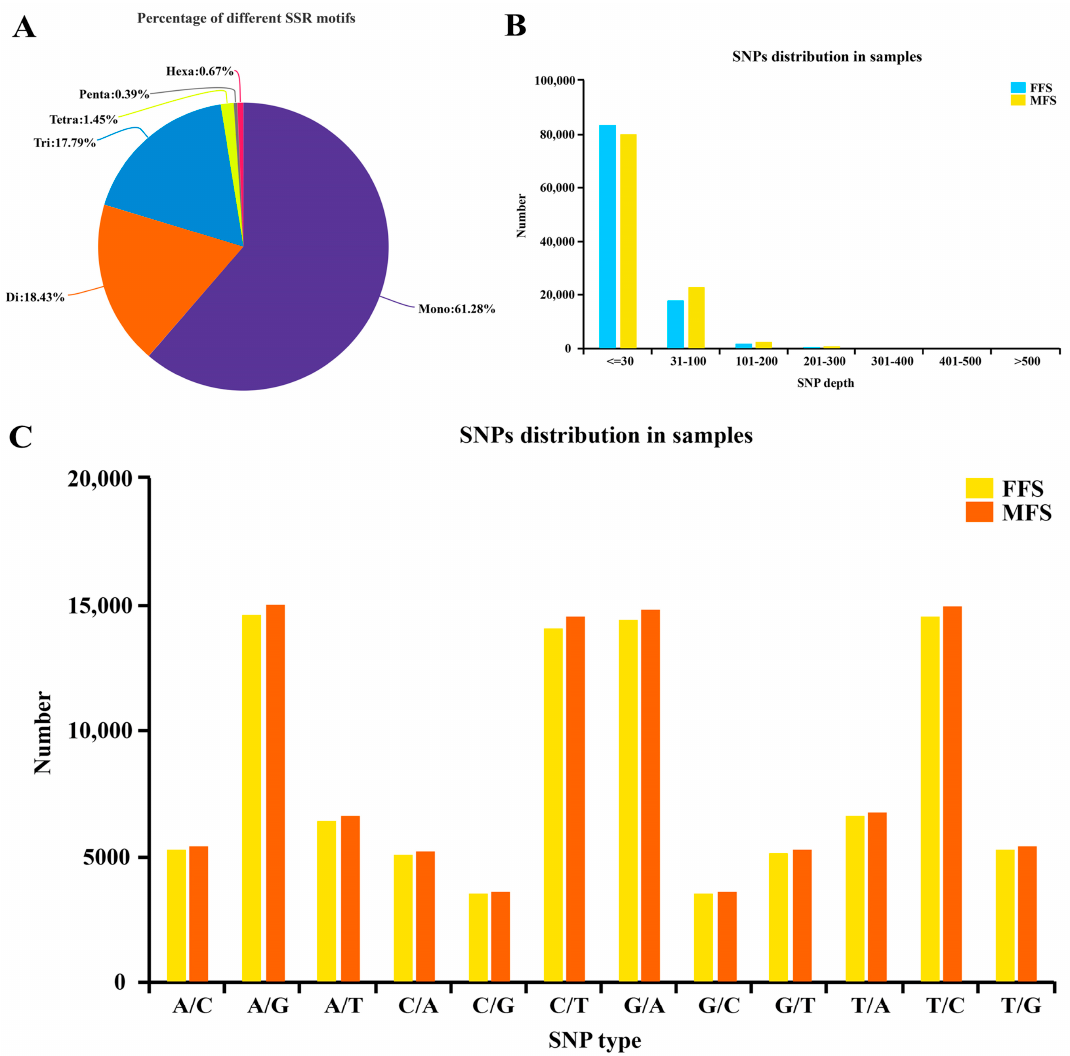
Figure 4. ( A ) Distribution of different types of SSRs identified in the Z. armatum ; ( B ) statistic of the SNPs length distribution in MFS and FFS; ( C ) SNPs distribution in samples (include substitution and transversion).